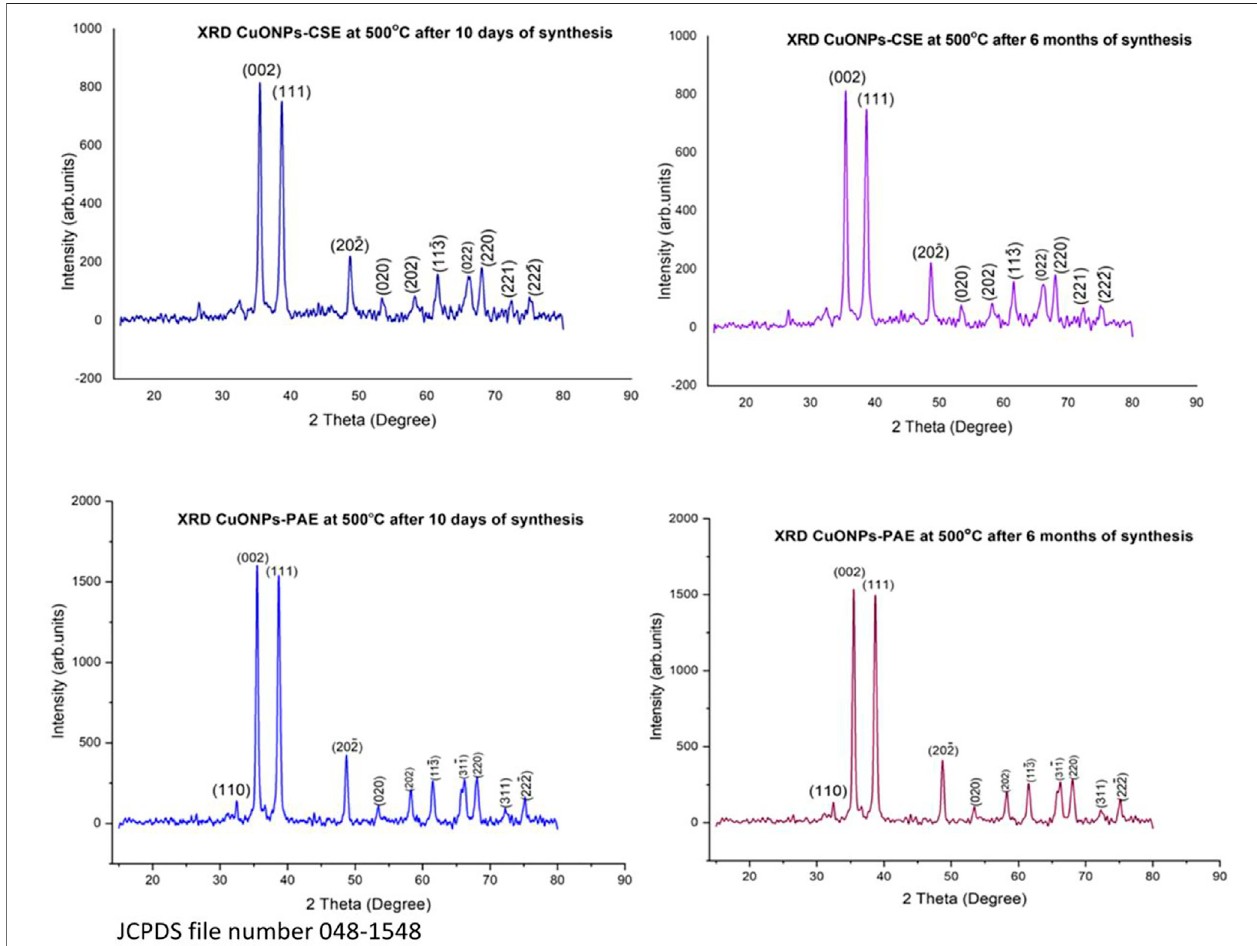
FIGURE 2 | XRD pattern for phytosynthesized copper oxide